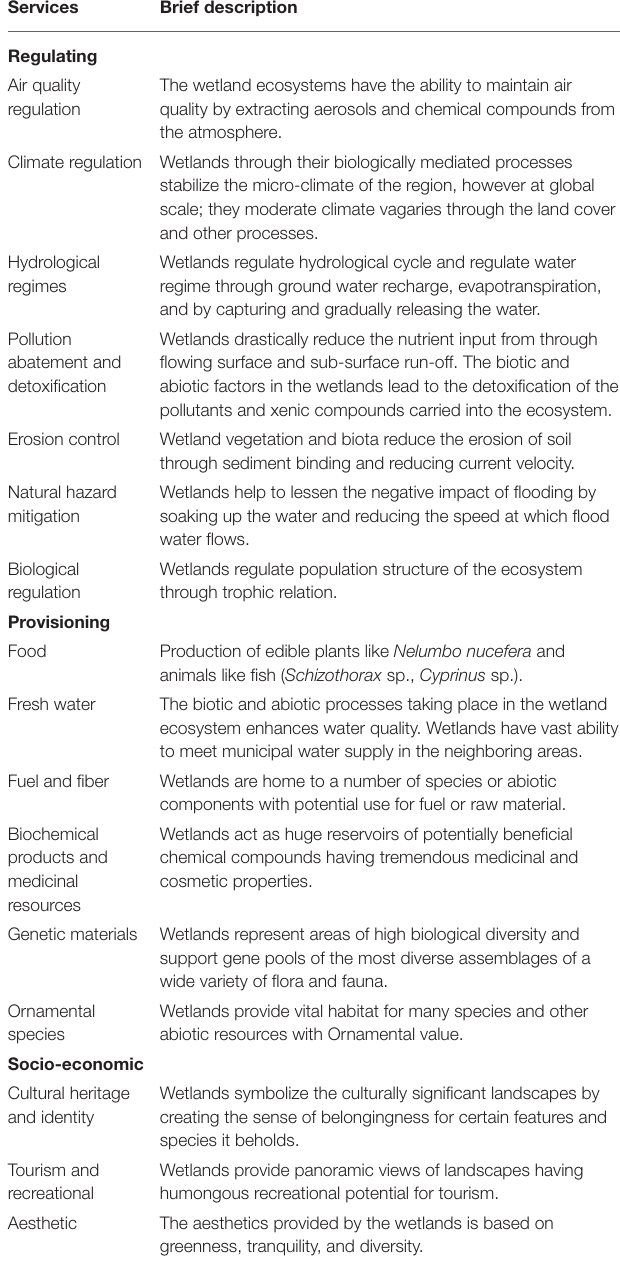
TABLE 7 | Ecological and socio-economic importance of